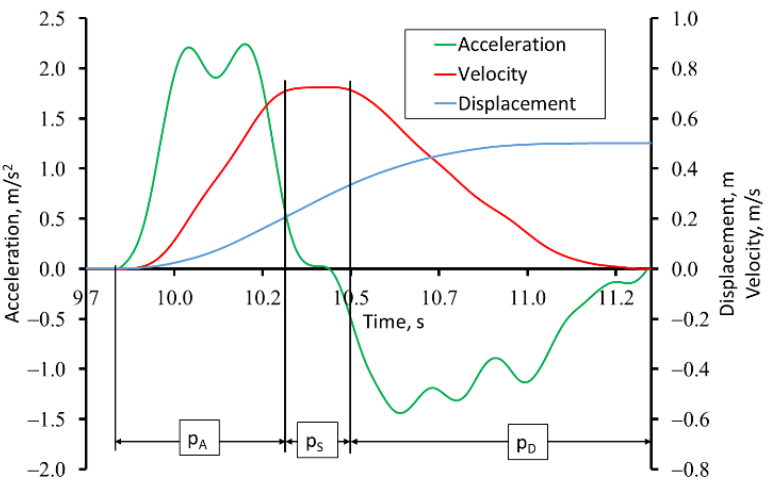
Figure 17. The course of displacement, velocity and acceleration obtained during tests of precise hand movement.